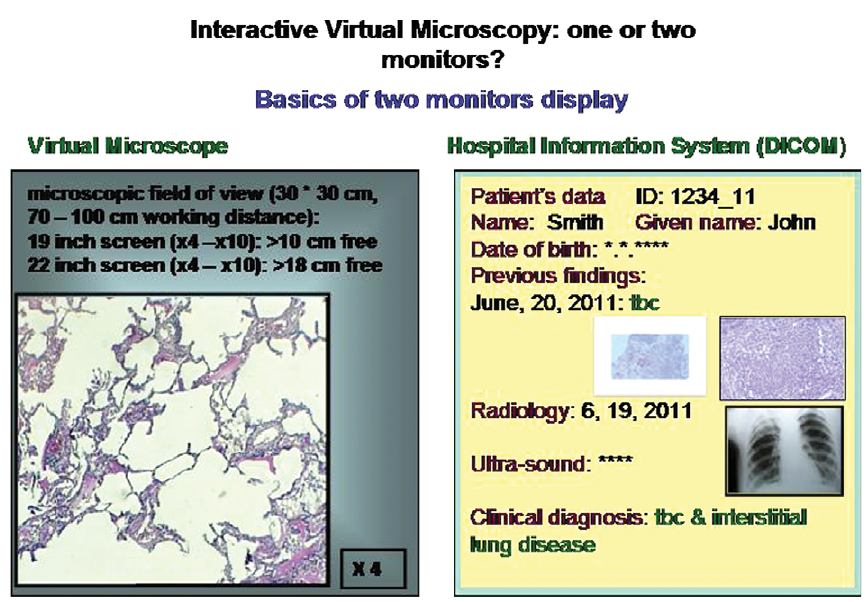
Fig. 4. Basic scheme of information display in a two-monitor VM